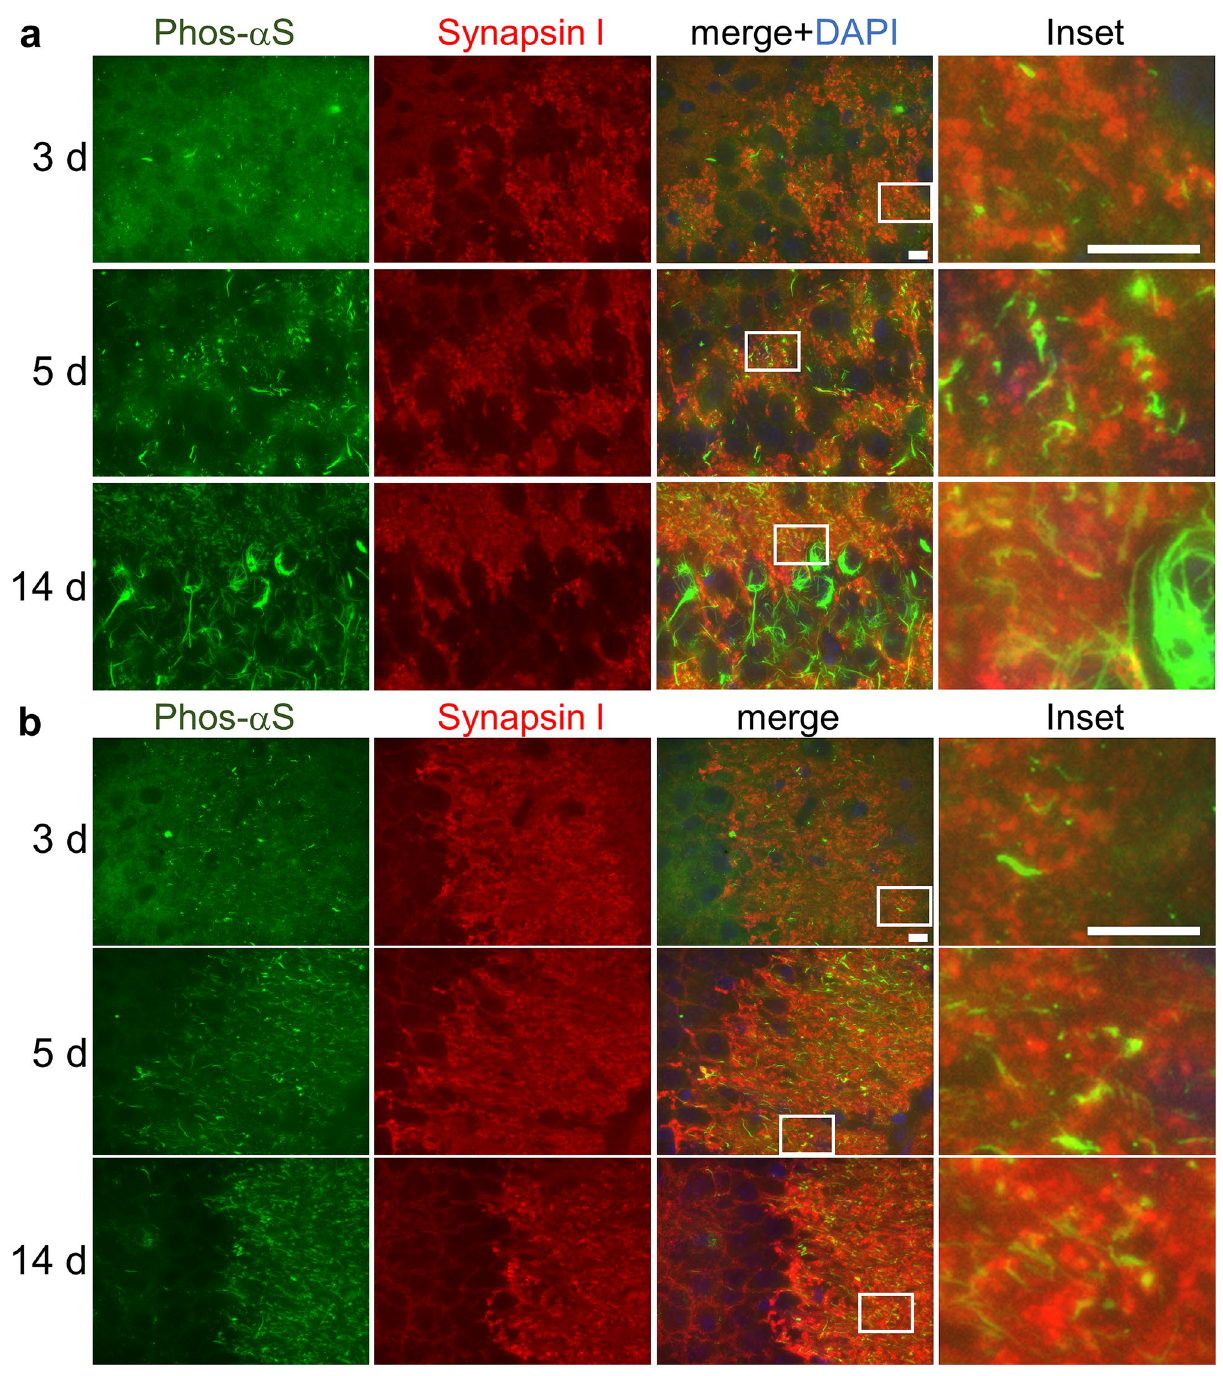
Figure 2. Seed-dependent phosphorylation of α-synuclein in pre-synaptic regions of mouse neurons. ( a ) Appearance of phosphorylated α-synuclein (Phos-αS) in the CA3c region at 3 days (upper), 5 days (middle) or 14 days (lower) after the injection. Images show phosphorylated α-synuclein (green), synapsin I (red), a presynaptic region marker, DAPI (blue) and the merged image in the CA3c region. Regions surrounded by white rectangles in merged images are magnified and shown in the rightmost panel of each lane. ( b ) Appearance of phosphorylated α-synuclein in the CA3a region at 3 days (upper), 5 days (middle) or 14 days (lower) after the injection. Images show phosphorylated α-synuclein (green), synapsin I (red), DAPI (blue) and the merged image in the CA3a region. Regions surrounded by white rectangles in merged images are magnified and shown in the rightmost panel of each lane. Scale bars, 10